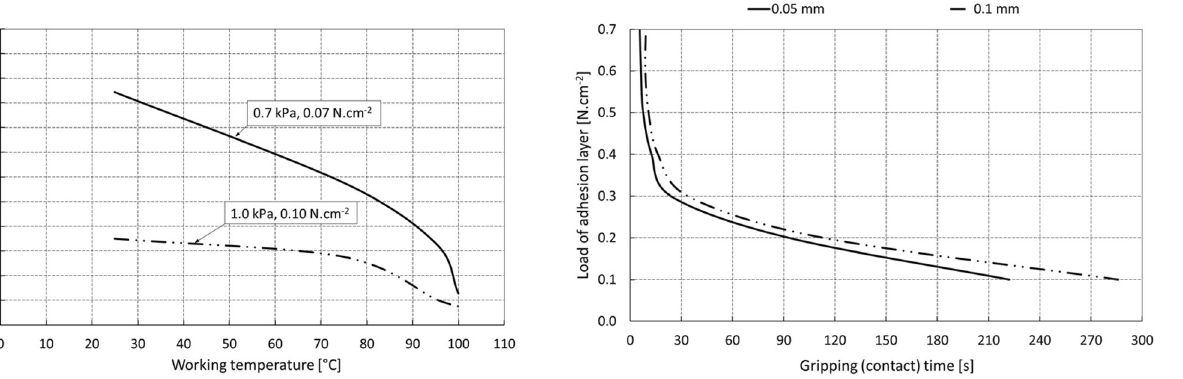
Fig. 13 Contact (gripping) time for the selected level of contact profile